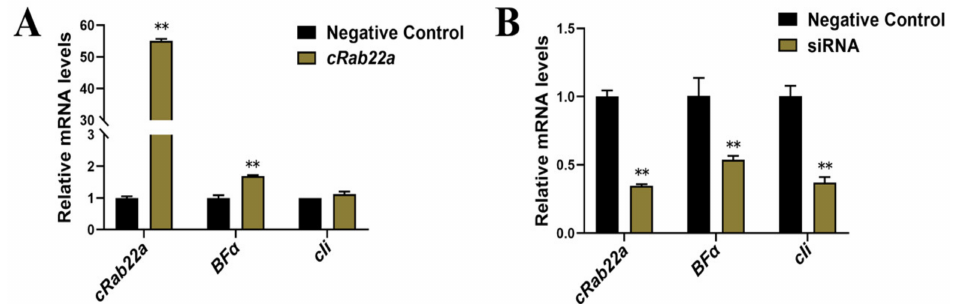
Figure 5. ( A ) The effects of cRab22a overexpression, and ( B ) the effect of cRab22a silencing (down- regulation) on the transcription level of BF α and cIi , ** indicates a highly significant difference ( p < 0.01).